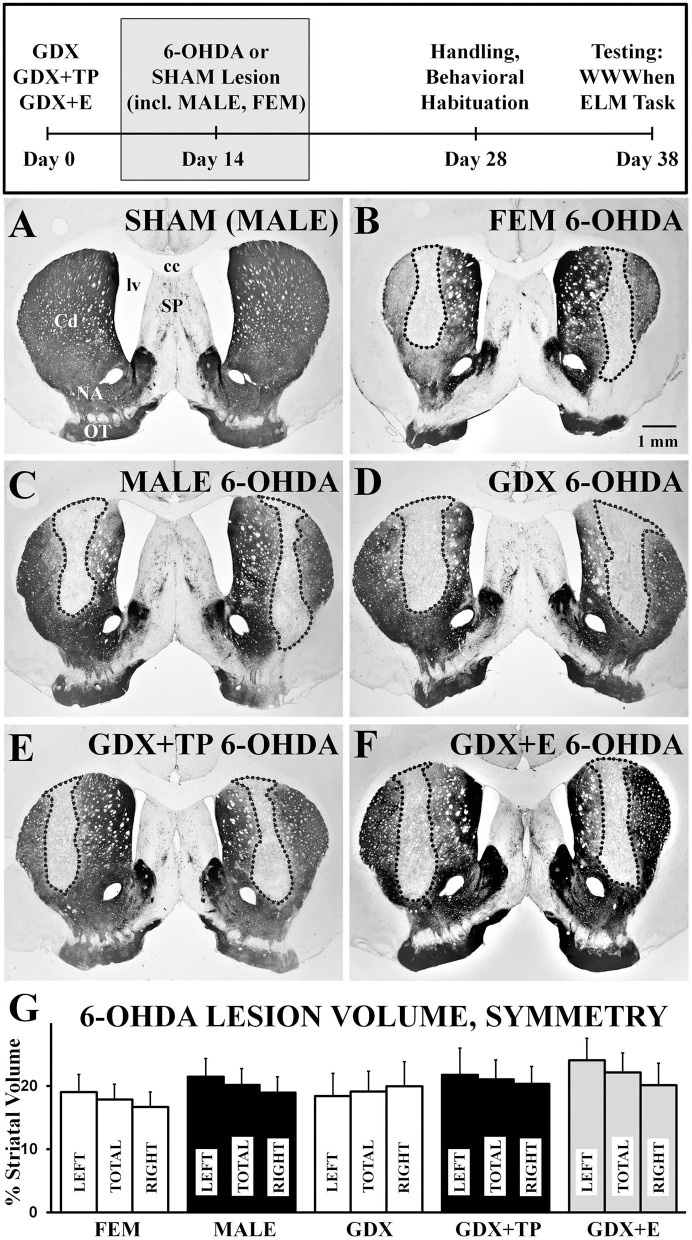
Representative low-power, brightfield light microscopic images of coronal sections through septal levels of the caudate nucleus (Cd) that are immunoreacted for tyrosine-hydroxylase (TH) (A–G). The section from a gonadally intact sham-operated male (A, SHAM) shows dense labeling throughout the caudate. Sections from a 6-hydroxydopamine (6-OHDA) lesioned female (B, FEM 6-OHDA), a 6-OHDA lesioned male (C, MALE 6-OHDA) and from 6-OHDA lesioned rats that were gonadectomized (D, GDX 6-OHDA), GDX and supplemented with testosterone propionate (E, GDX+TP 6-OHDA), or GDX and supplemented with 17β-estradiol (F, GDX+E 6-OHDA) all show discrete bilateral zones of diminished TH-immunostaining (outlined). The experimental timeline showing when lesions and sham lesion were made is shown above, and bar graphs (G) and bar graphs showing group average sizes and symmetries of 6-OHDA lesions, expressed as percentages of the left (LEFT), right (RIGHT), and total (TOTAL) caudate nucleus volumes ± standard error of the mean, are shown below for all groups below. cc, corpus callosum; NA, nucleus accumbens; SP, septal nucleus; lv, lateral ventricle; OT, olfactory tubercle. Scale bar in B = 1 mm.